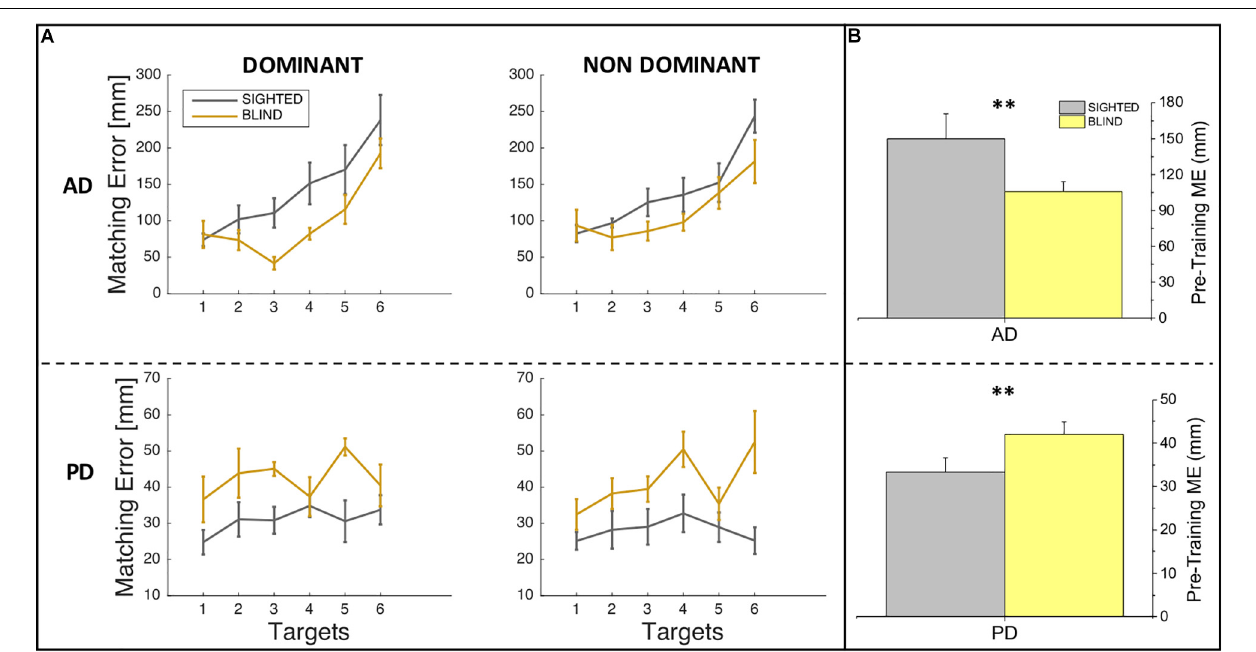
FIGURE 2 | Auditory and proprioceptive performance at the pre-training session. (A) The panel represents the auditory (top) and proprioceptive (bottom) matching errors (in mm) for the dominant (left) and non-dominant (right) arms. Results are shown for each target location and indicate that for the auditory but not for the proprioceptive domain, matching error increases therefore performance decreases with increasing target location distance. (B) The panel represents the auditory (top) and proprioceptive (bottom) matching errors (in mm) independently of the arm trained (dominant, non-dominant). Results indicate that blind participants outperformed sighted participants in the auditory domain, while sighted participants outperformed blind participants in the proprioceptive domain. ∗∗ Indicates p -values < 0.01.